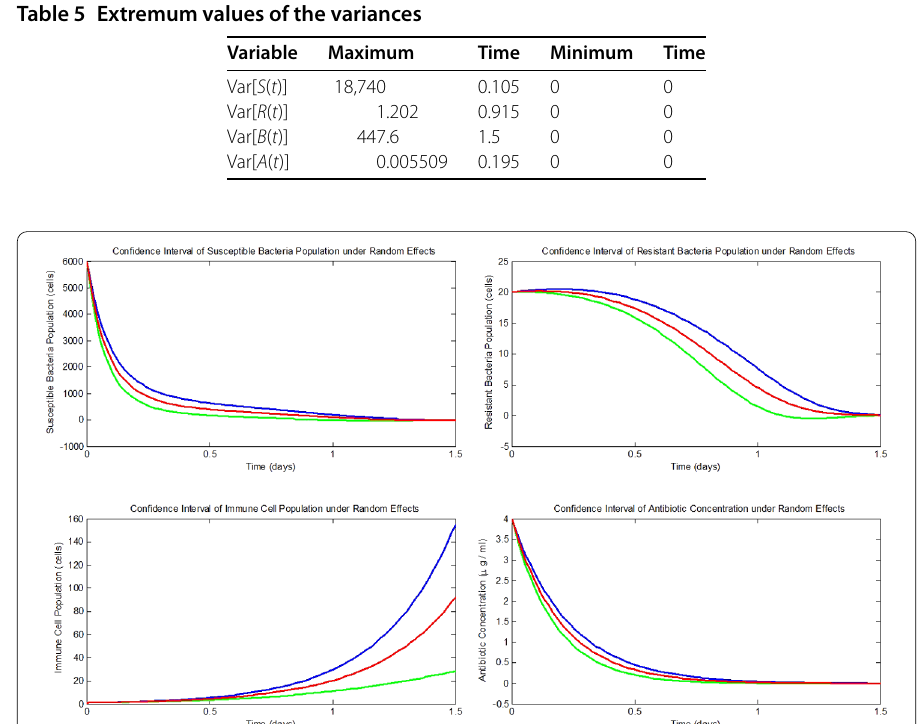
Figure 8 Confidence intervals of the random